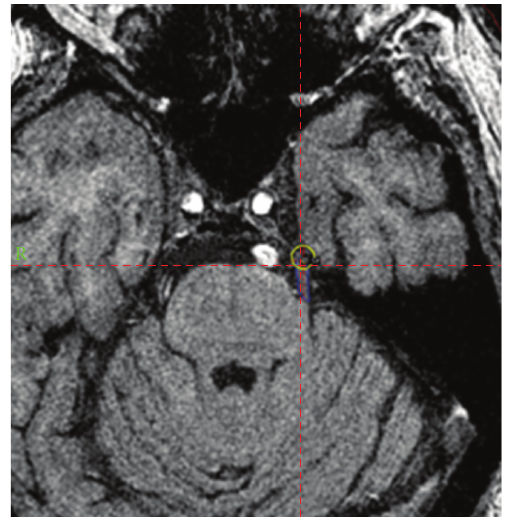
Figure 2: Axial section through the brainstem at the nerve root entry zone of the left trigeminal nerve with an illustration of the location of the 50% isodose line for the gamma knife radiation treatment planning. This was the location of treatment for his third course of